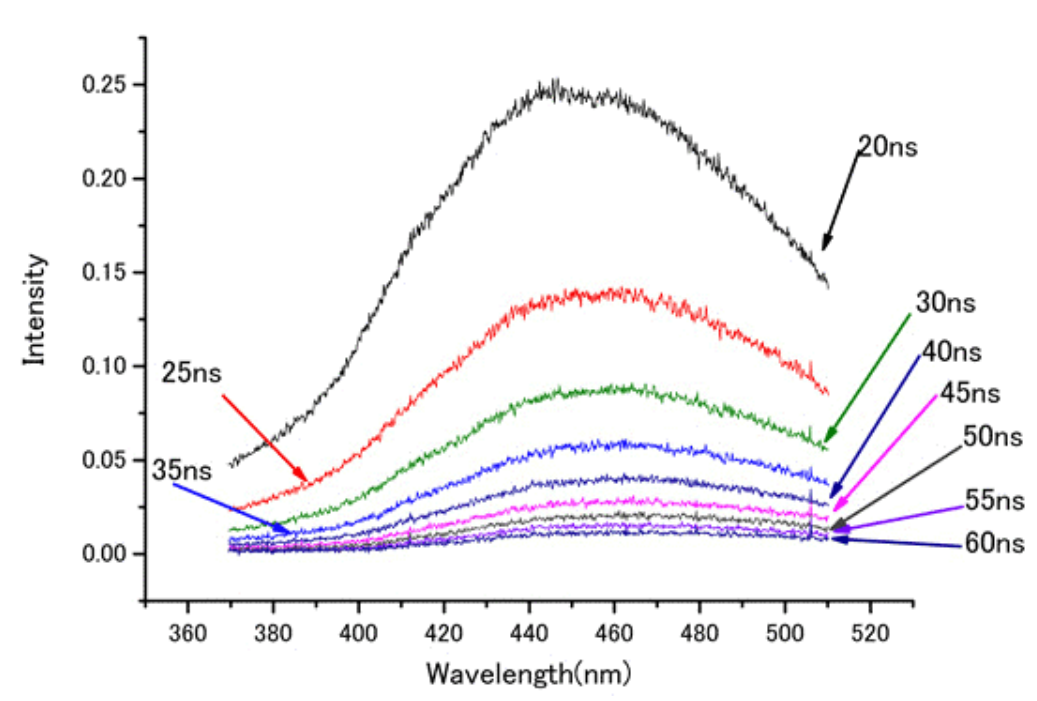
FIGURE 12. Time-resolved spectra of peak B. These are the same as in Fig. 9, but without spectra for 10- and 15-nsec delay time. These are shown only to inspect details of spectra with more than 20-nsec delay time.